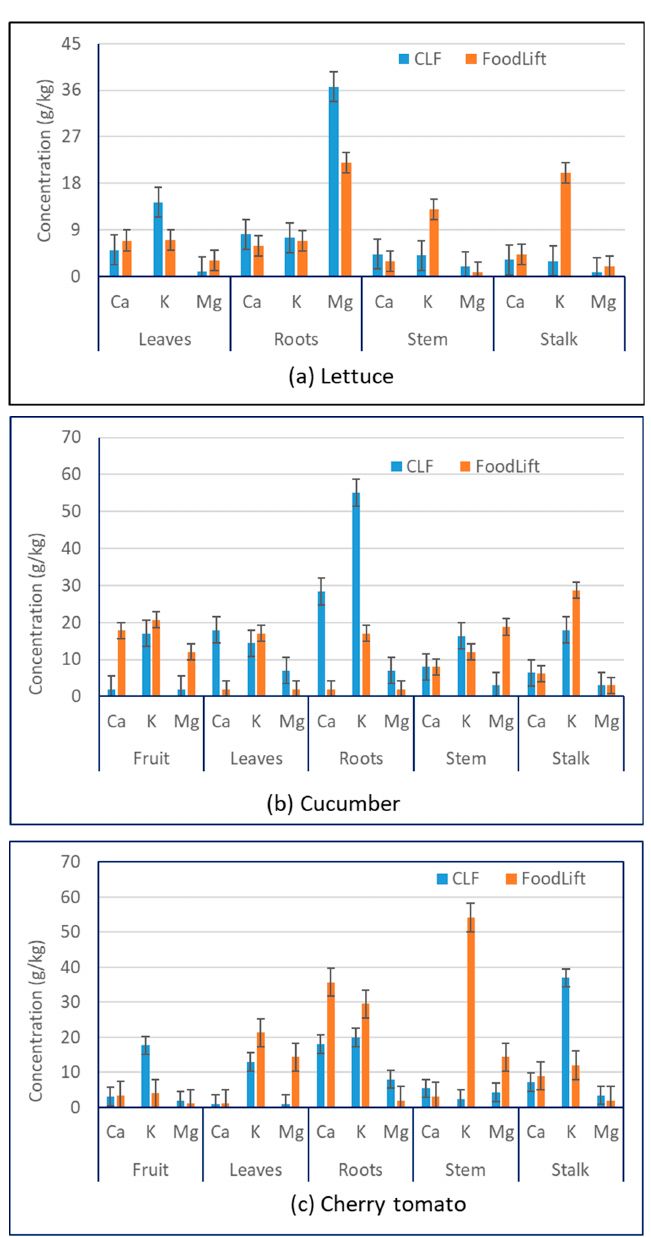
Figure 3. Calcium, potassium, and magnesium concentrations in different structural parts of ( a ) let- tuce, ( b ) cucumber, and ( c ) tomato plants (error bars indicate standard deviation (SD) values).